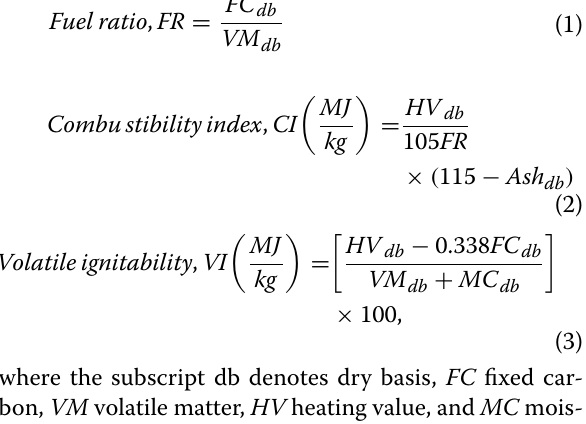
Table 5 Effect of torrefaction on the combustion indices of briquettes